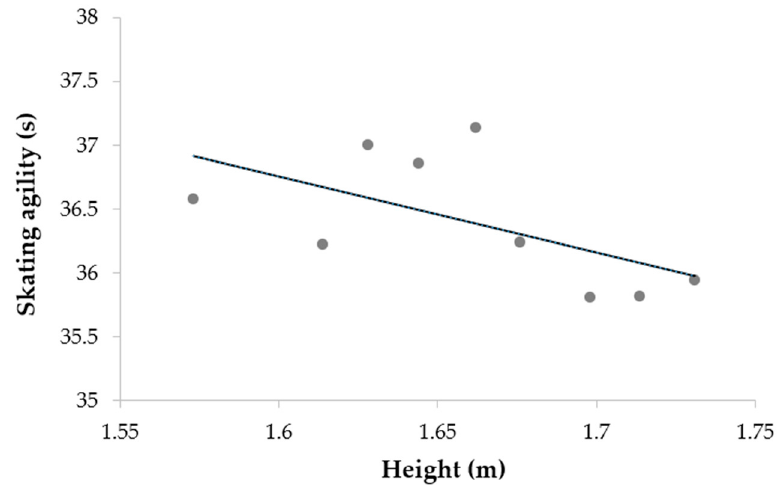
Figure 5. Association between height and skating agility test (seconds).